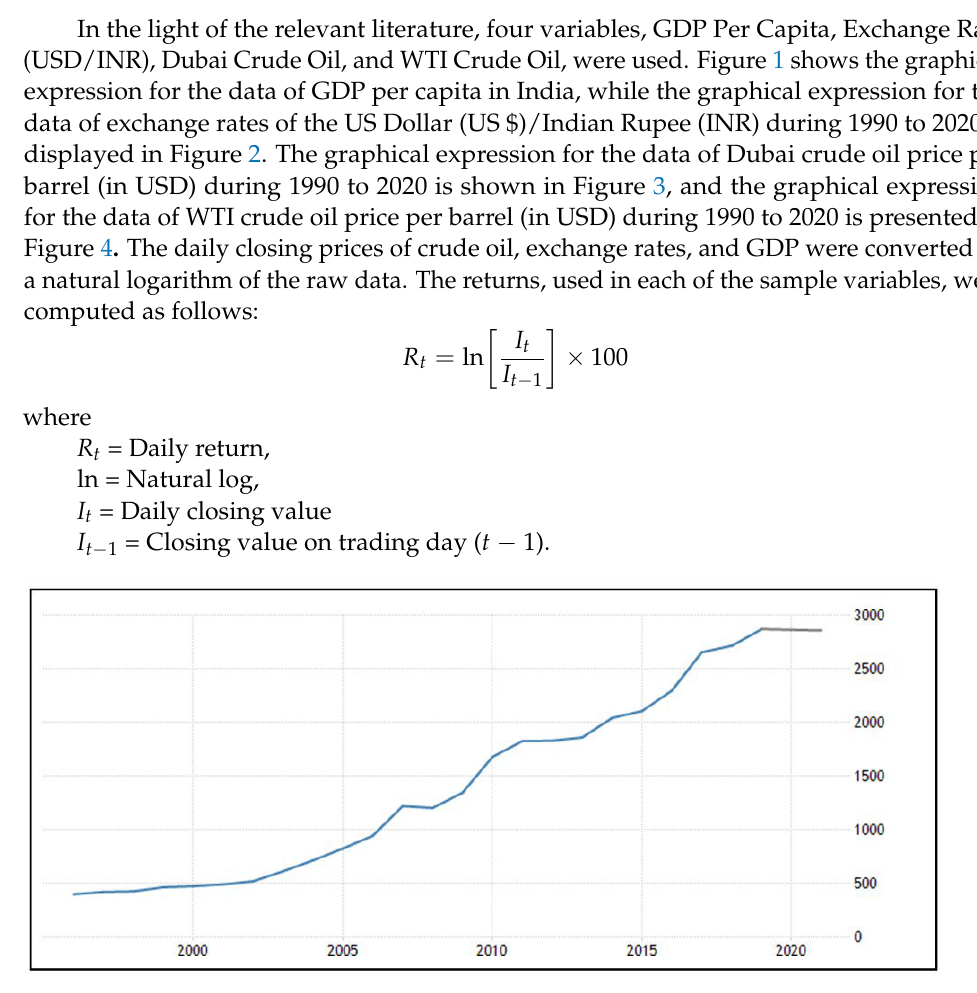
Figure 1. Graphical Expression for the Data of GDP per Capita in India during 1990 to 2020; Sources: Compiled from https://databank.worldbank.org/home.aspx and computed using E.Views-10.